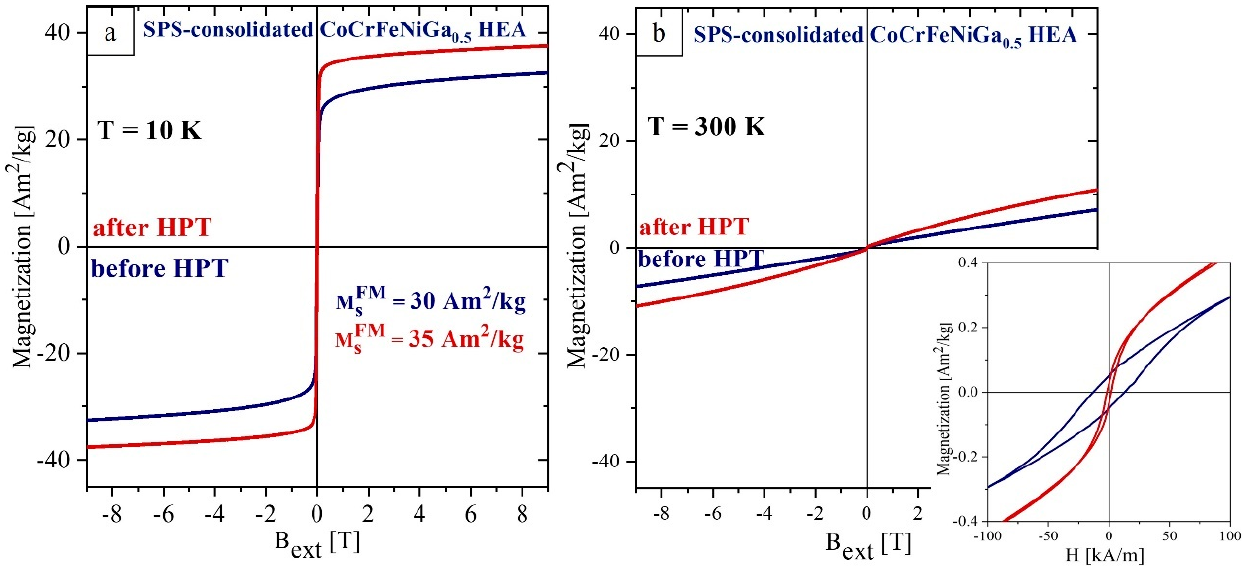
Figure 8. Field dependence of magnetization recorded at 10 K ( a ) and at 300 K ( b ) for SPS-consolidated CoCrFeNiGa 0.5 HEA before (blue) and after (red) HPT. Insert M(H) at low fields.